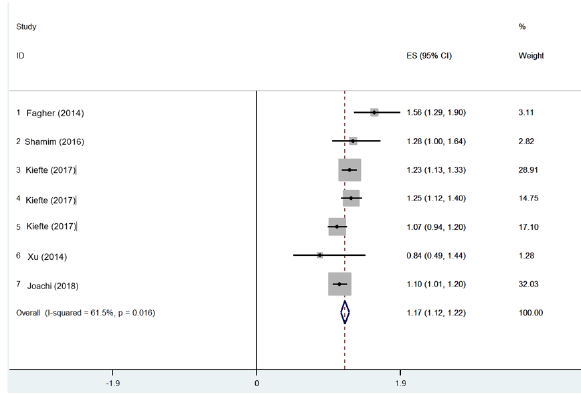
Figure 2. Forest Plot for the odds ratio of the relationship between dietary acid load and the incidence of diabetes.